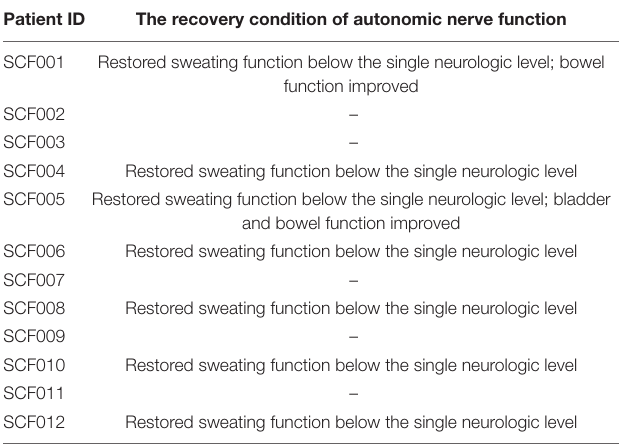
TABLE 4 | The recovery condition of autonomic nerve function in paraplegic patients at 6 months postoperatively. Patient ID